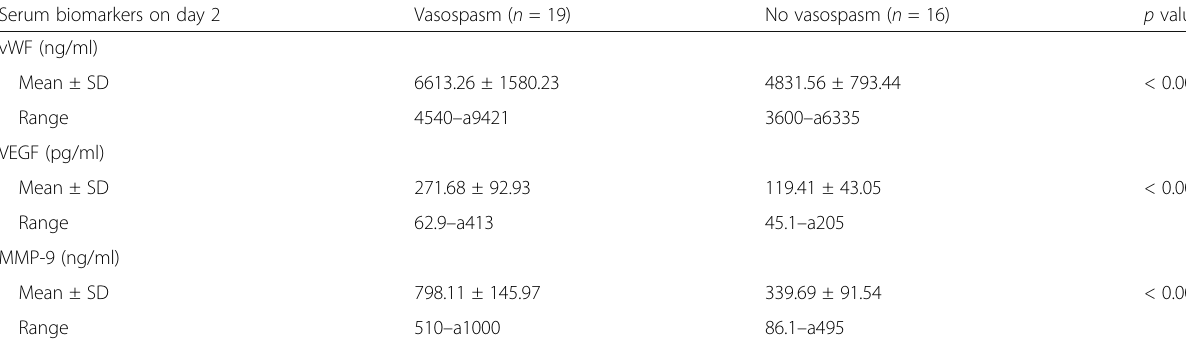
Table 2 Comparison between CV and non-CV groups in relation to serum biomarkers concentrations Serum biomarkers on day